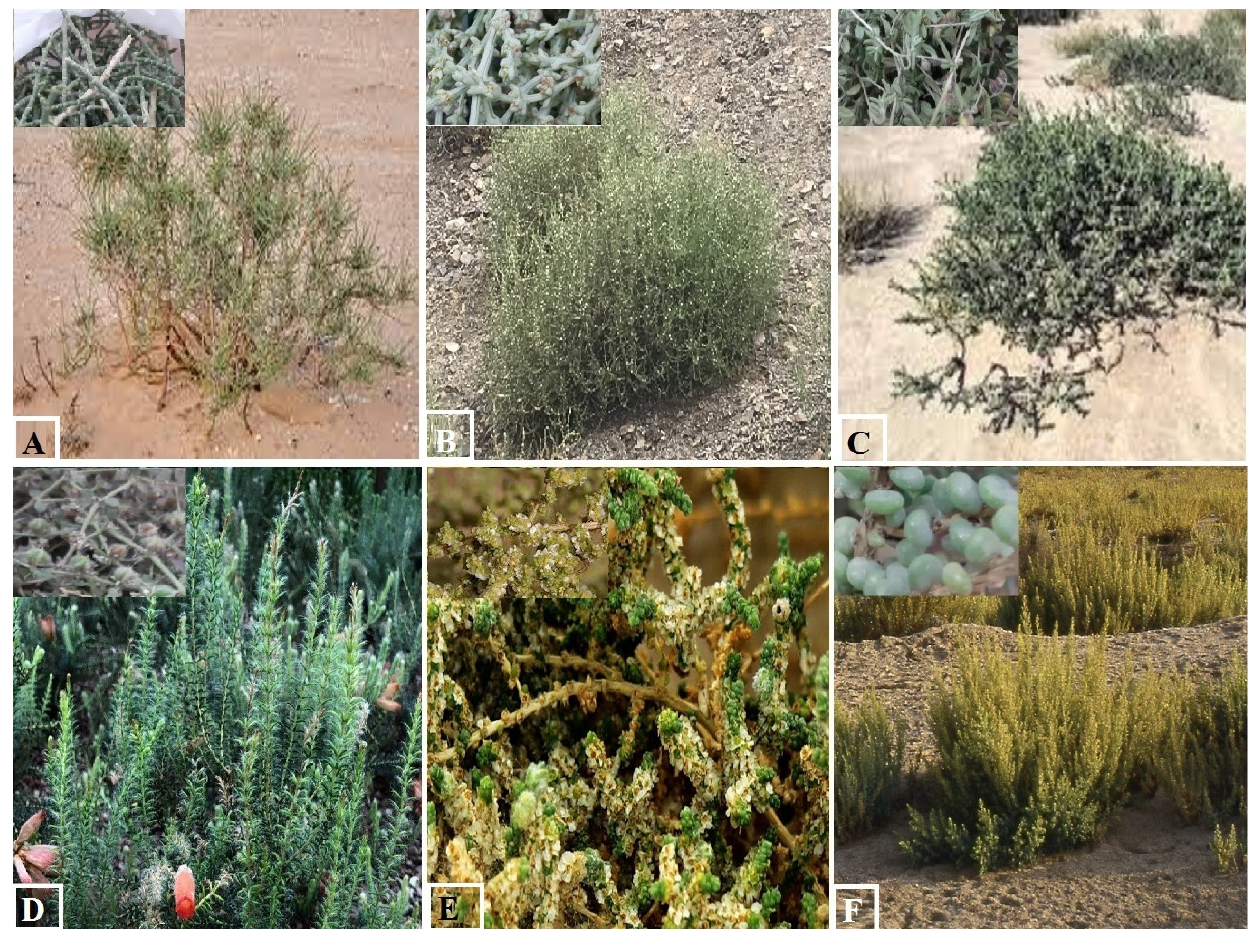
Figure 2. The six wild plants of the present study. ( A ). Haloxylon salicornicum , ( B ). Salsola kali , ( C ). Heliotropium bacciferum , ( D ). Erica verticillata , ( E ). Salsola imbricata and ( F ). Bienertia sinuspersici .